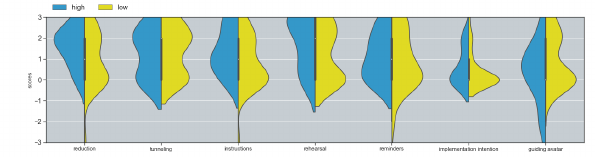
Figure 5. Motivational design techniques regarding ability.